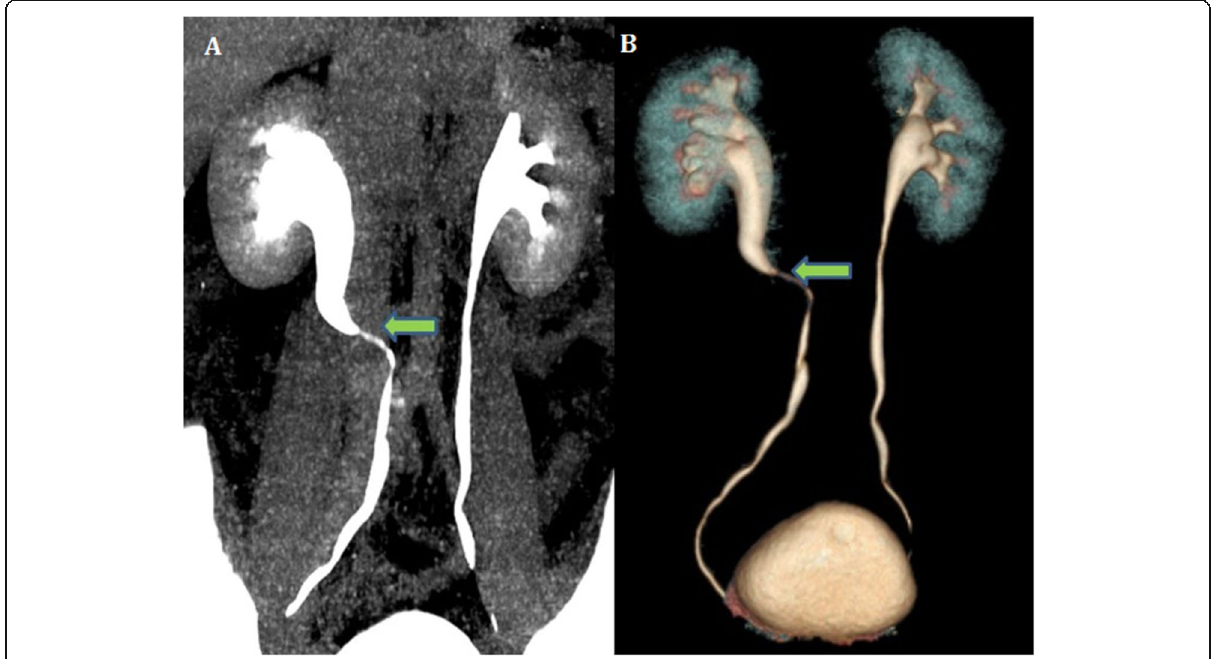
Fig. 11 Same patient as in Fig. 10 with retrocaval ureter. Coronal reformatted MIP ( a ) and volume-rendered 3D ( b ) images show the narrowed